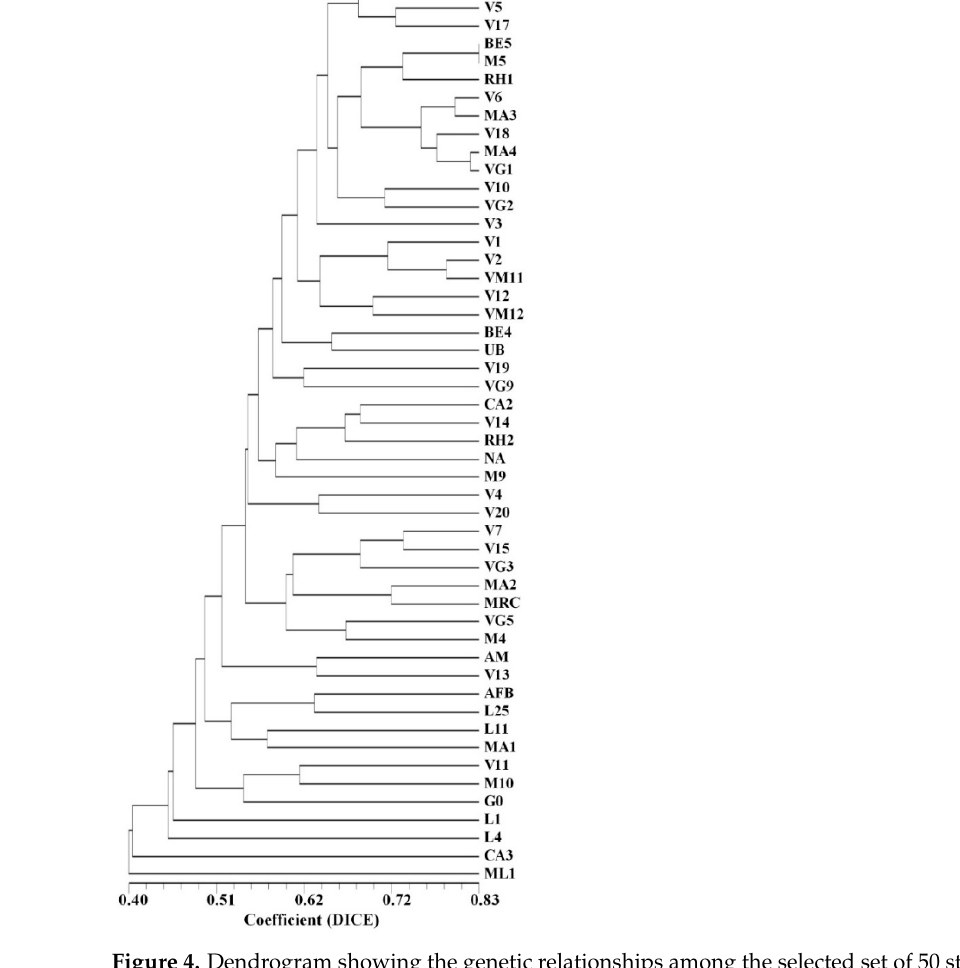
Figure 4. Dendrogram showing the genetic relationships among the selected set of 50 strawberry tree ( Arbutus unedo L.) germplasm accessions, established based on the merged results of the performed SSR and SNP-CAPS analyses.